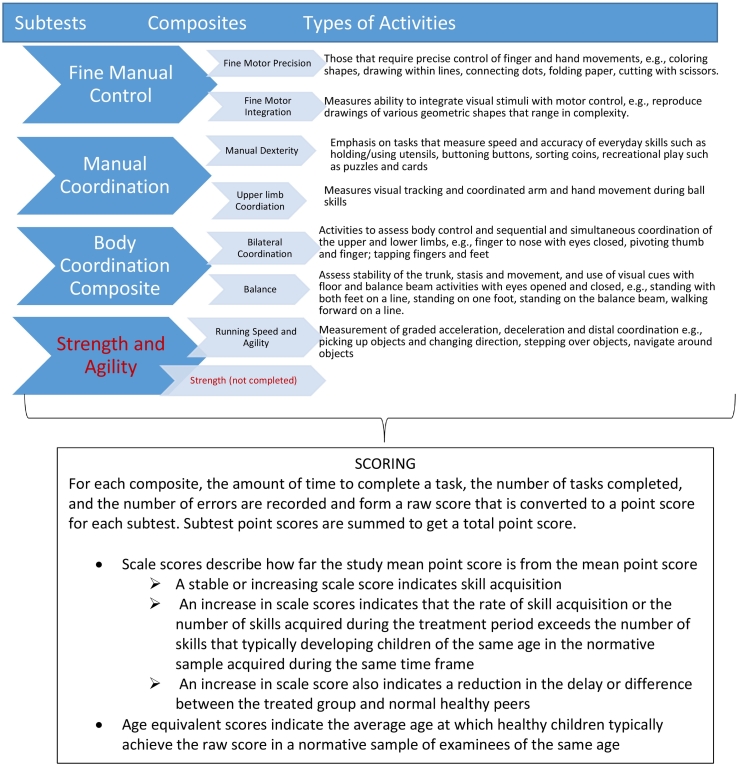
The BOT-2 test includes subtests for fine motor precision, fine motor integration. Manual dexterity, upper limb and bilateral coordination, balance, running speed and agility, and strength. Subset point scores can be used to derive scaled and age-adjusted scores in pediatric patients.